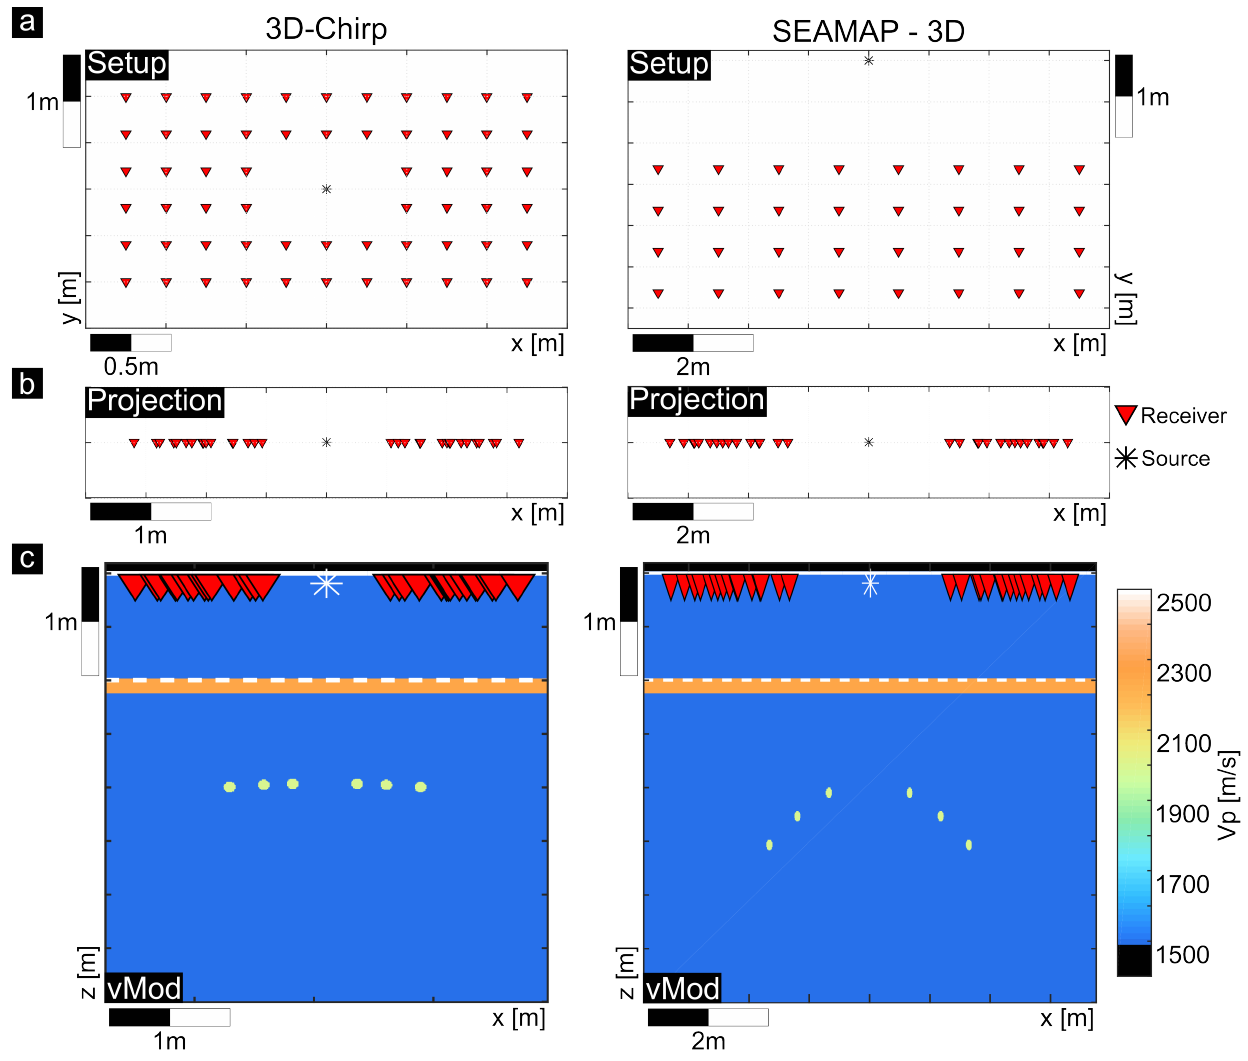
Figure 7. Setup, projection to the x-plane, and velocity models for both the 3D-Chirp ( left ) and SEAMAP-3D ( right ) systems. The 3D setup of both systems ( a ) is projected to the x-plane with all source-receiver offsets ( b ). Velocity models including scattering objects in a depth equaling the travel time of the first bottom multiple are shown in panel ( c